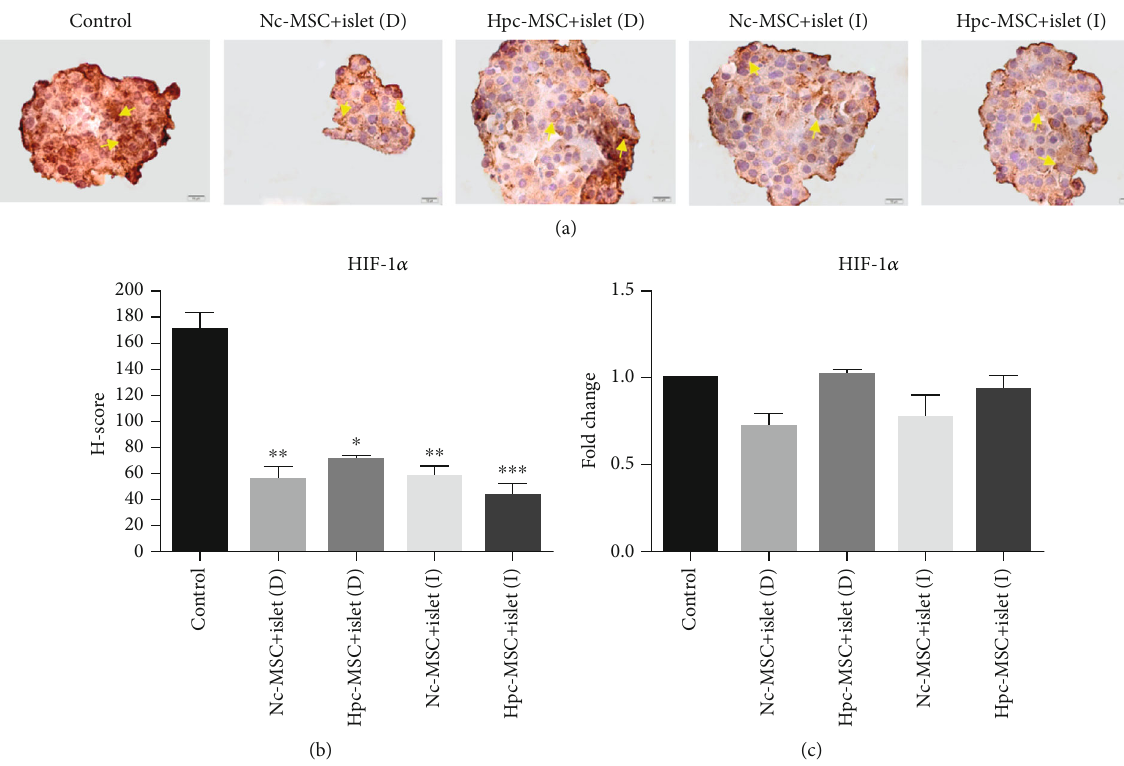
Figure 7: HIF-1 α protein and mRNA expression in human islets cocultured with Hpc-MSCs and Nc-MSCs. (a) HIF-1 α protein immunocytochemistry. (b) HIF-1 α protein level in the islets expressed as graphs based on the H-score method. (c) HIF-1 α gene expression in the islets. A comparison was done between the control and each cocultured islets (yellow arrows show positive protein expression). Scale bar: 10 μ m. ∗ P < 0 : 05 and ∗∗ P < 0 : 01 . Nc-MSCs: normoxia condition mesenchymal stem cells; Hpc-MSCs: hypoxia preconditioning MSCs; D: direct coculture; I: indirect